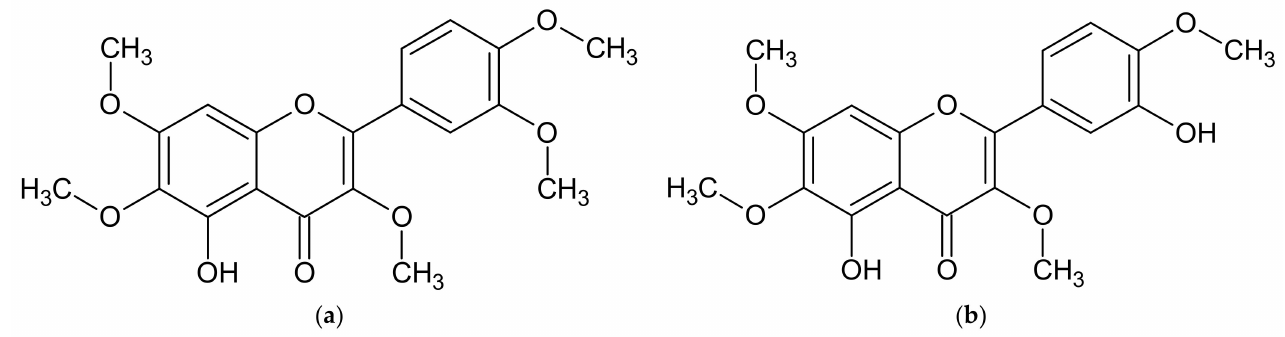
Figure 2. Chemical structure of flavonoids found in Artemisia species: artemetin ( a ); casticin ( b ).